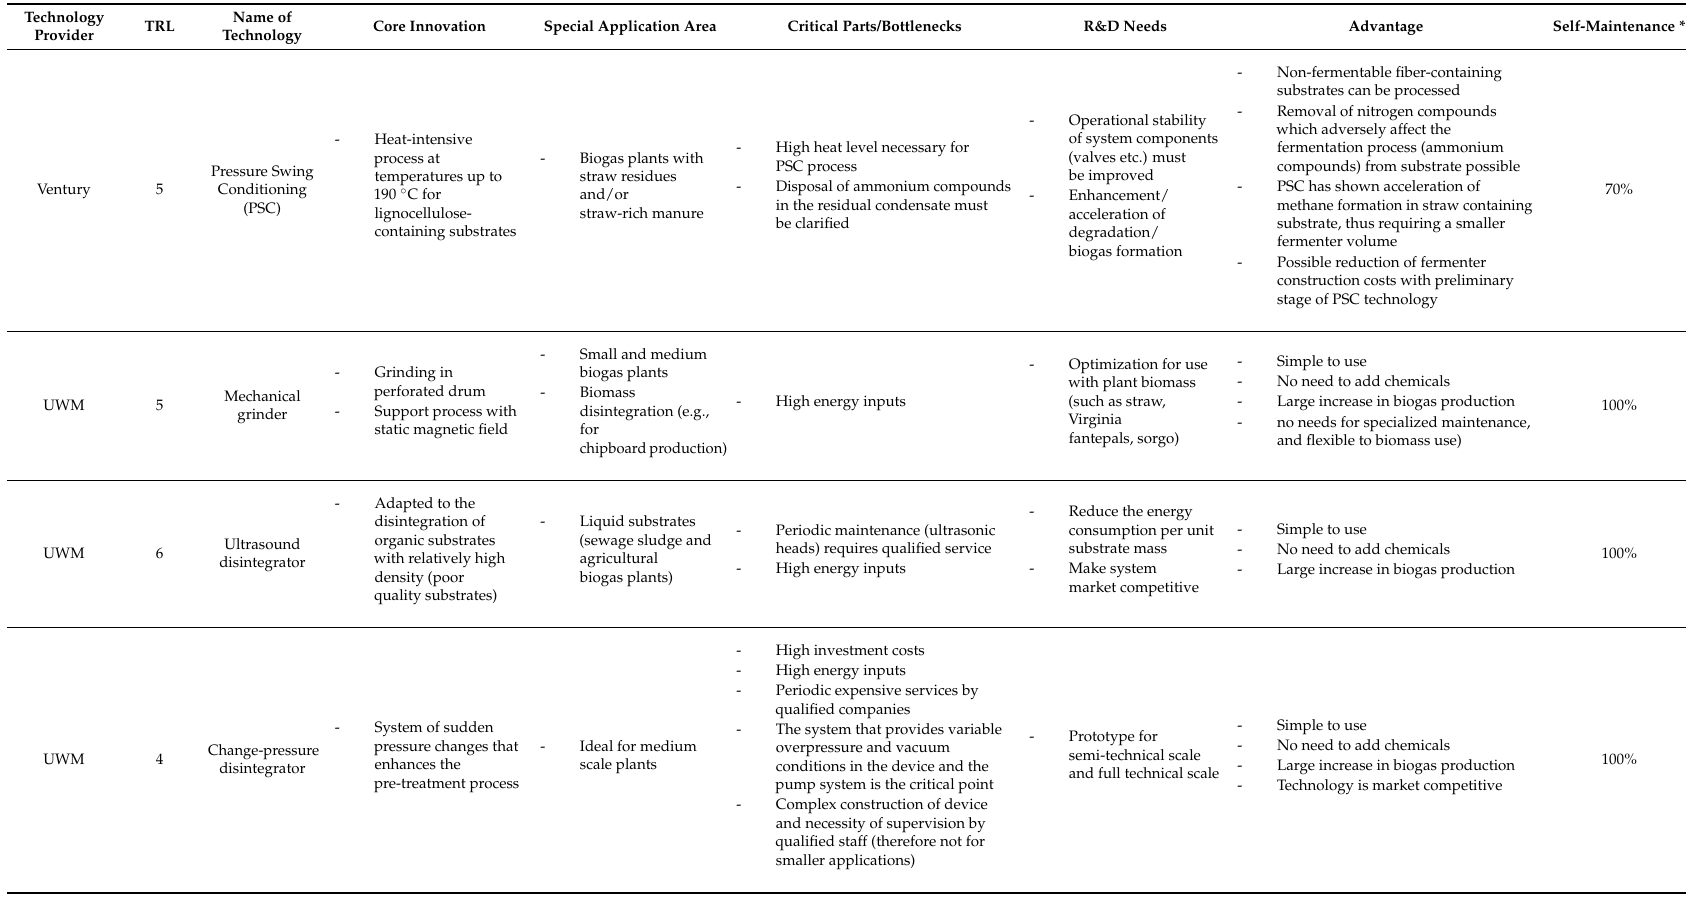
Table A1. Additional information for pre-treatment